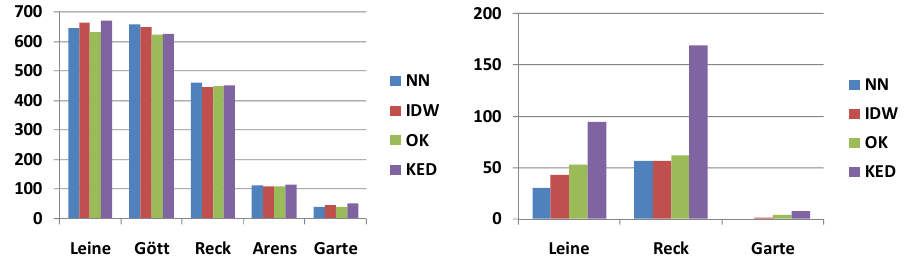
Fig. 5. Results of strategy III, number of “good” realisations for each gauge (Leineturm (Leine), G¨ottingen (G¨ott), Reckershausen (Reck), Arenshausen (Arens), and Gartem¨uhle (Garte)) and interpolation method with NSE ≥ 0.5, discharge on the left, nitrate load on the